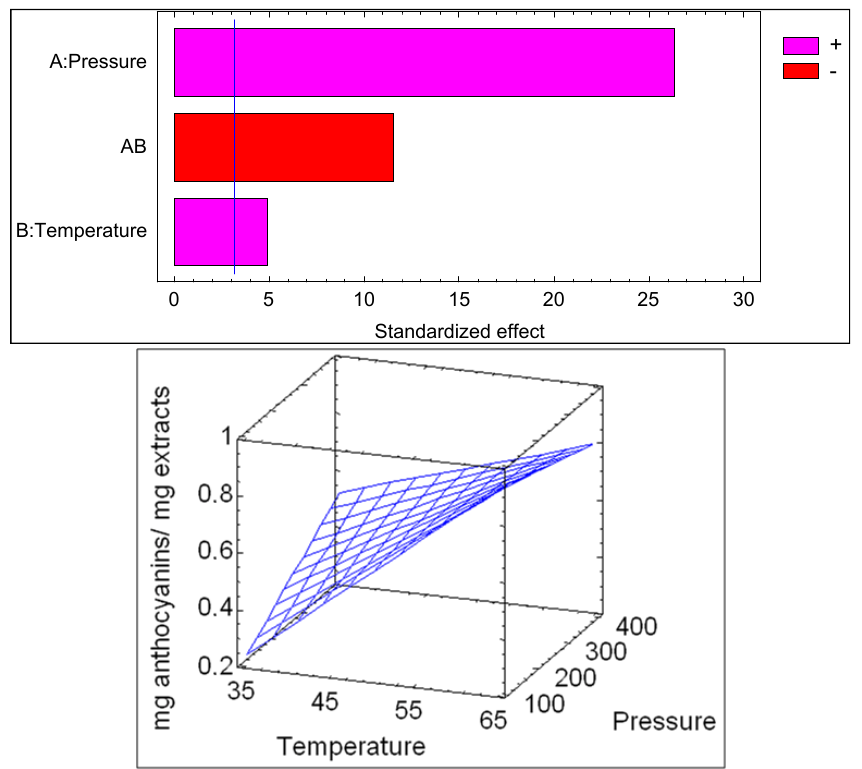
Figure 3. Pareto diagram and response surface for the SFE of anthocyanins with respect to extraction temperatures and